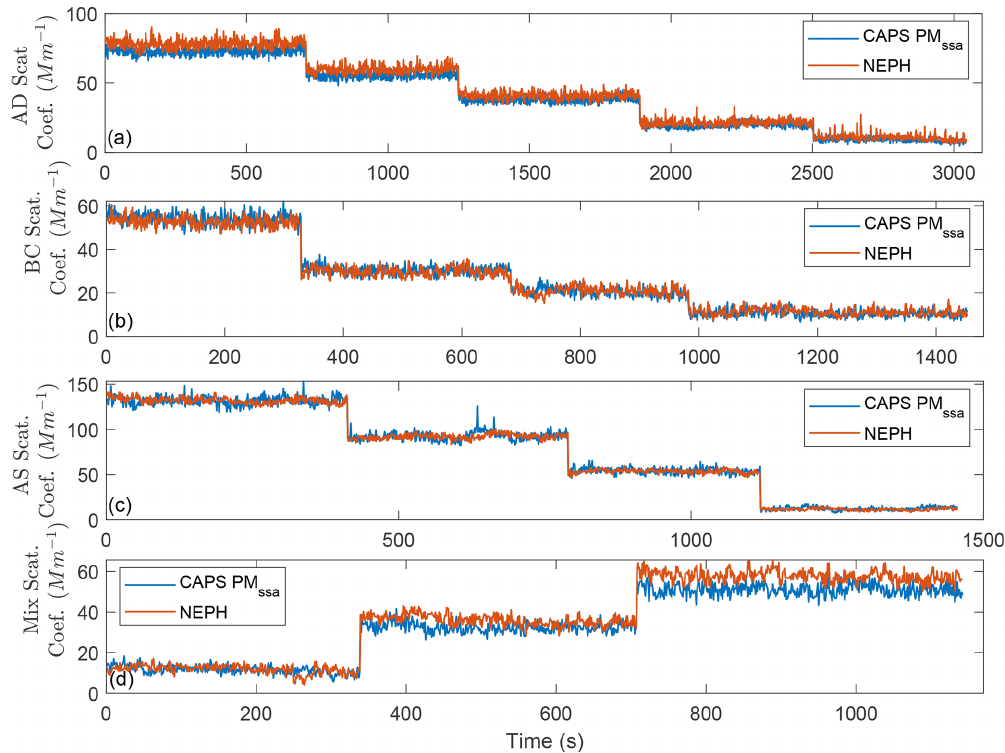
Figure 8. Time series (1Hz) of σ sp simultaneously measured by the different instruments: CAPS PM SSA and NEPH for the different aerosol types ( a AD, b BC, c AS and d mix).